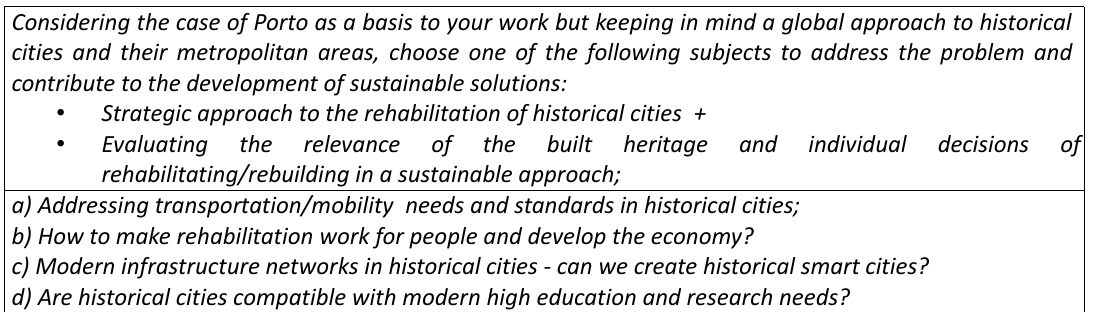
Table 1. PBL Themes for group